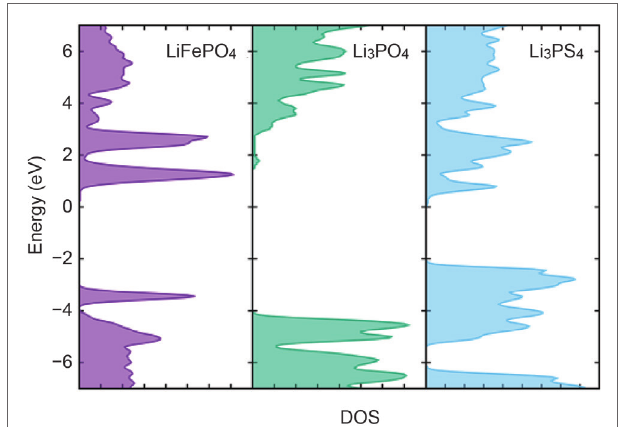
FigUre 3 | Density of states calculated for liFePO 4 , li 3 PO 4 , and li 3 Ps 4 . Zero in energy is set to the Fermi level of Li metal.